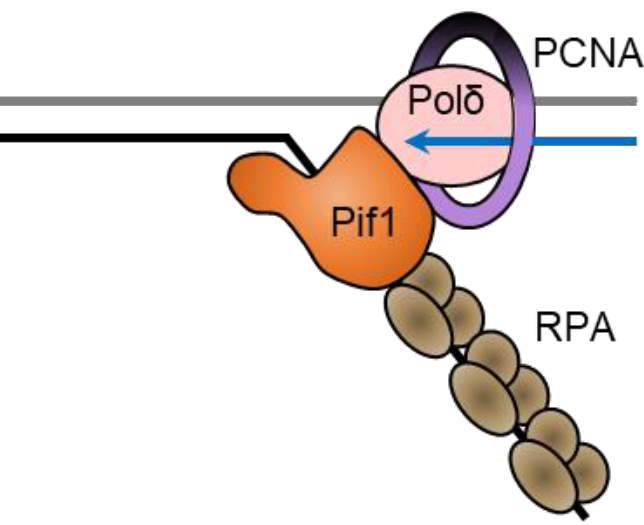
Figure 5. Extension of the 5′-flap of an Okazaki fragment by Pif1 provides a binding site for RPA that makes it resistant to cleavage by FEN1. makes it resistant to cleavage by